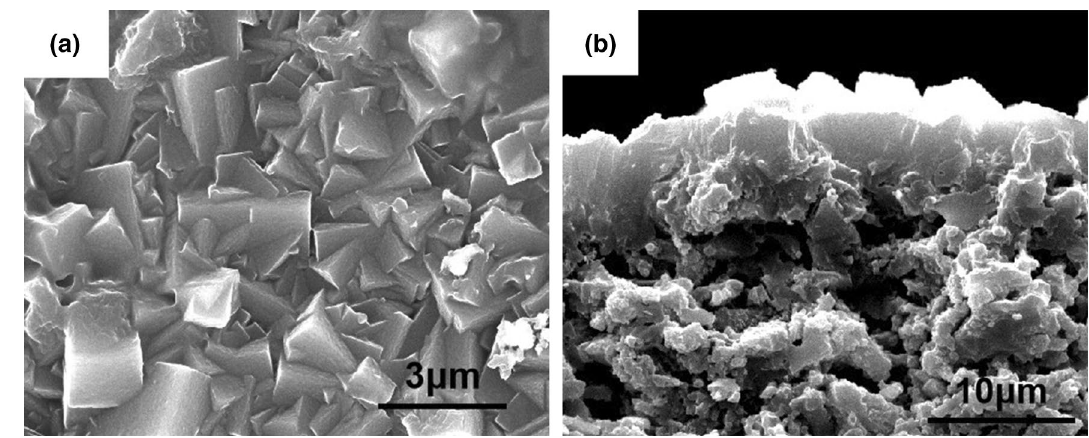
Fig. 9 SEM photos of surface ( a ) and cross section ( b ) of zeolite NaA membrane that formed on the sample sintered at temperatures of 1500 °C